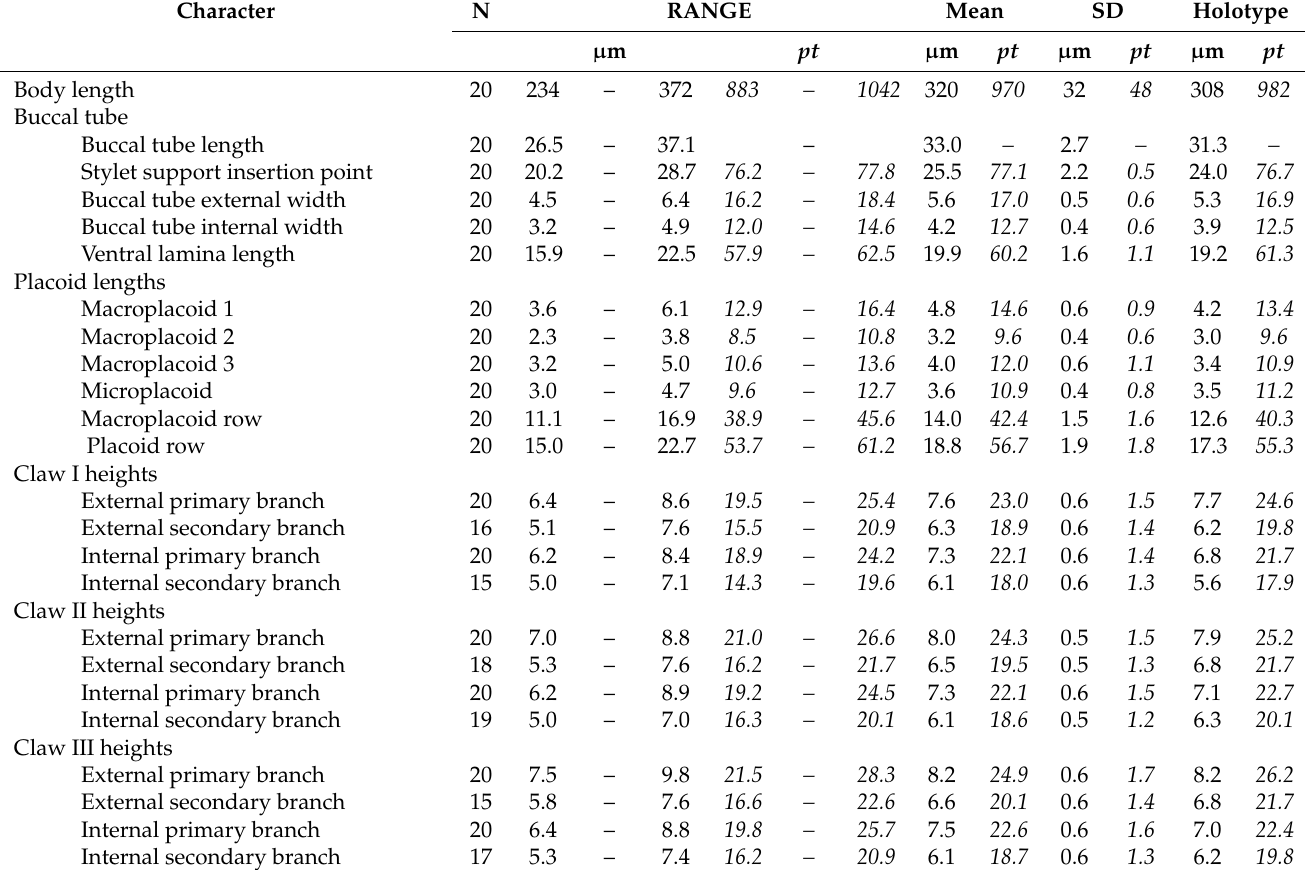
Table 5. Measurements [in µ m] and pt values of selected morphological structures of animals of Mesobiotus marmoreus sp. nov. ; specimens mounted in Hoyer’s medium; N—number of specimen/structures measured, RANGE refers to the smallest and the largest structure among all measured specimens; SD—standard